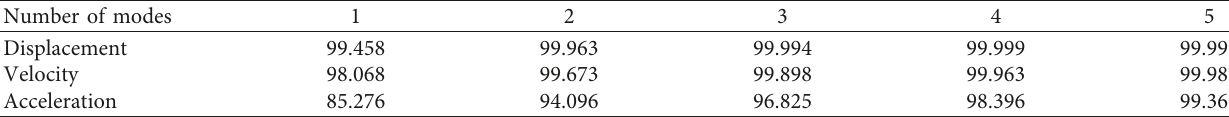
Figure 13: Coordinate system. Table 9: Energy contribution ratio of the first five modal responses.